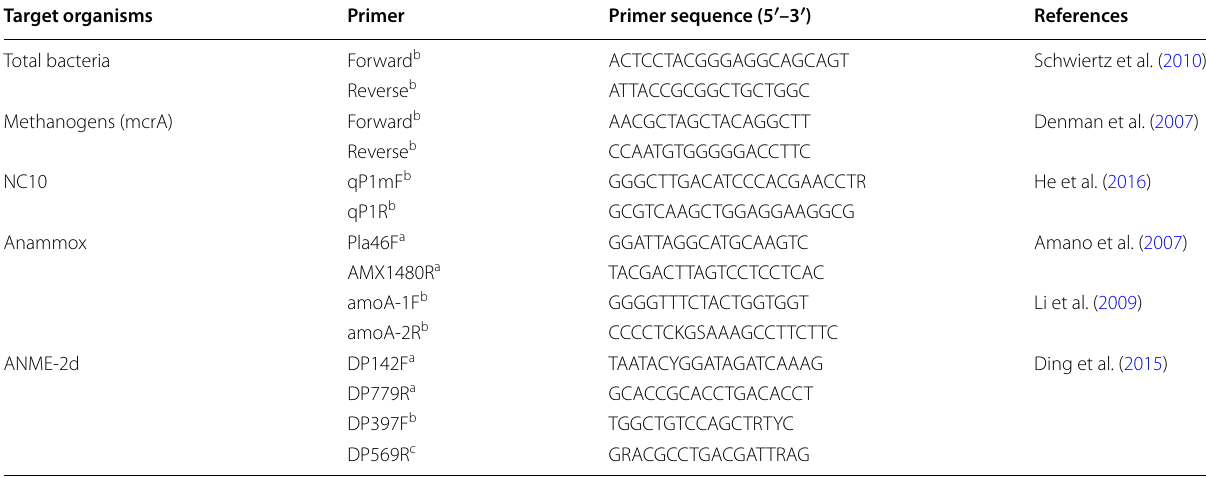
Table 1 The specific primers for PCR and